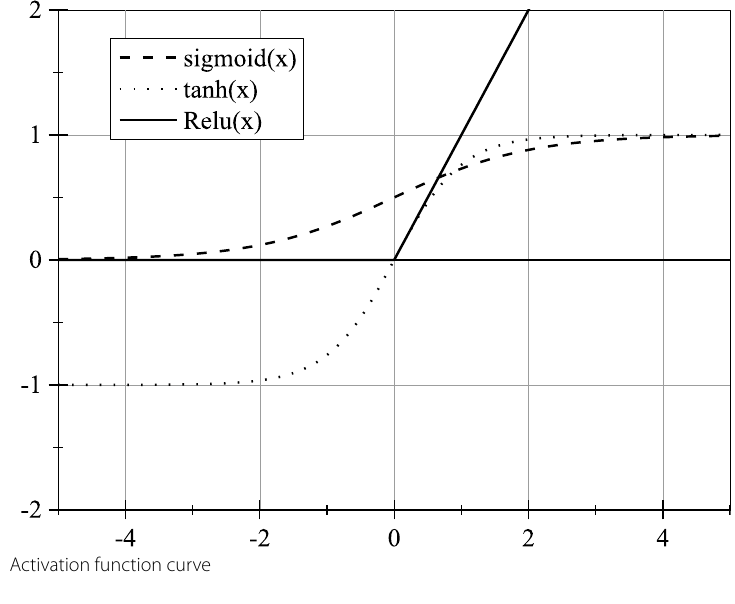
Fig. 10 Activation function curve